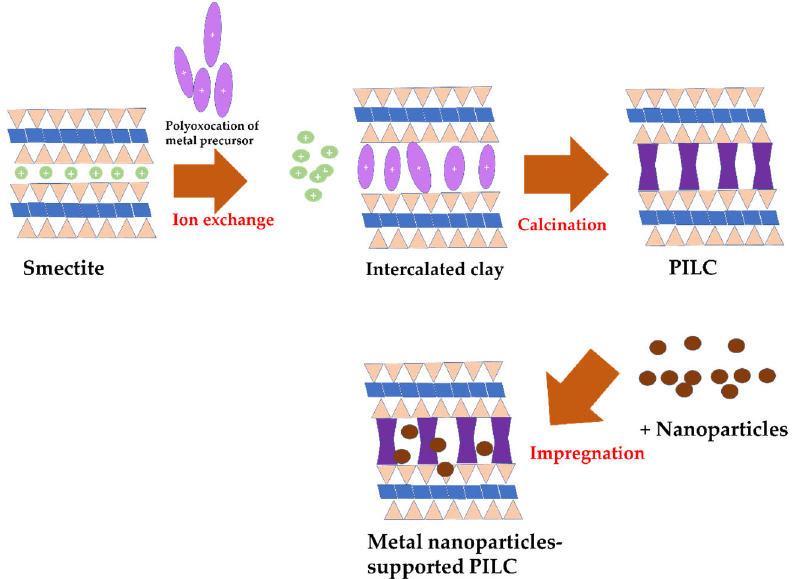
Figure 10. Schematic representation of metal nanoparticle impregnation onto PILC. Combinations such as TiO 2 -impregnated Fe-pillared clay (TiO 2 /Fe-PILC), Fe-impregnated Co-pillared clay (Fe/Co-PILC), Ru-impregnated Ti-pillared clay (Zn/Fe-PILC), and Co/Al-PILC exhibited hybrid properties for gaining either homogeneous dispersion or material stability, which are sufficiently accommodating for surface interactions for the catalytic process [147–150]. The immobilized Co 2+ and Sn 2+ have been proven as successful catalysts for dye oxidation. On tartrazine oxidation using oxone, Co/Al-PILC was demonstrated to be a stable and efficient catalyst in the degradation of both tartrazine and the detected products [150].